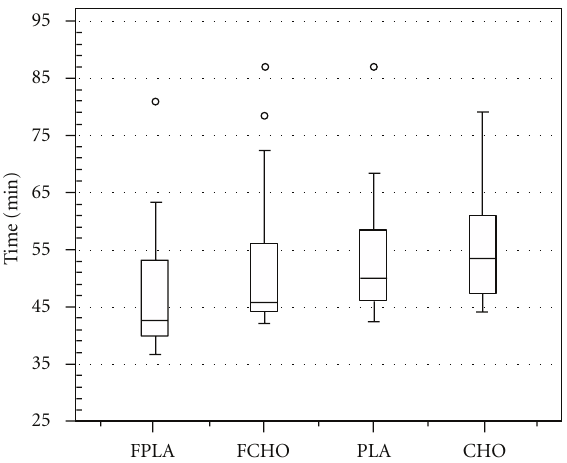
Figure 1: Time-to-exhaustion. Boxplot of the time-to-exhaustion for the 4 di ff erent trials (FCHO: carbohydrate rinse in fasted state; FPLA: placebo in fasted state; CHO: carbohydrate rinse in fed state; PLA: placebo in fed state). The thick line in the boxes represents the median, the extremes of the boxes the 25 and 75% percentiles, and the whiskers the minimum and maximum values. Outliers are indicated by a circle when more than 1.5times the interquartile ran- ges beyond the 75%